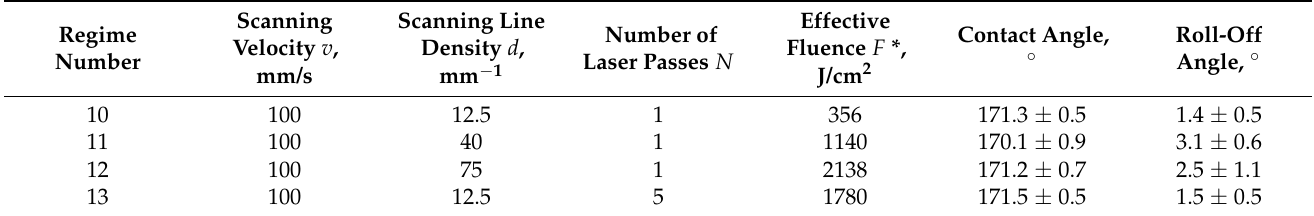
Table 2. The parameters of laser texturing applied in combination with sample heating on the electric plate, and wettability characteristics of the obtained